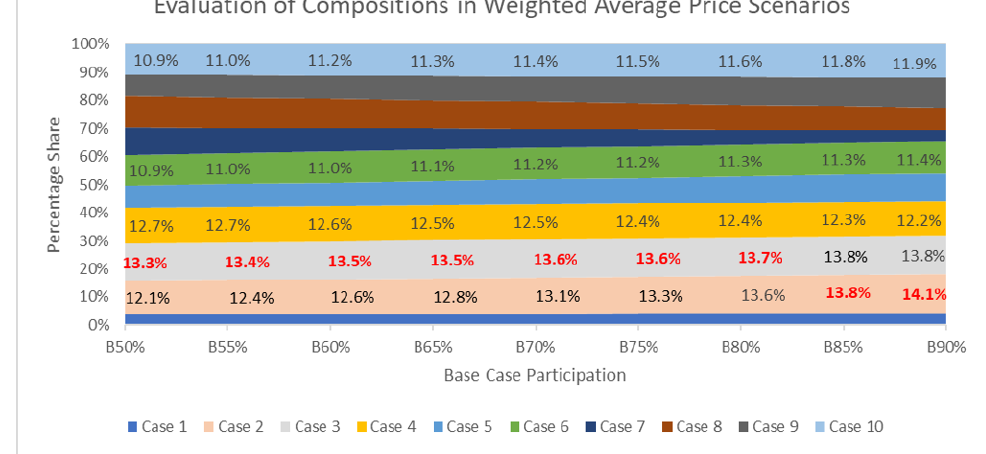
Figure 9. Identification of the best distribution of RD